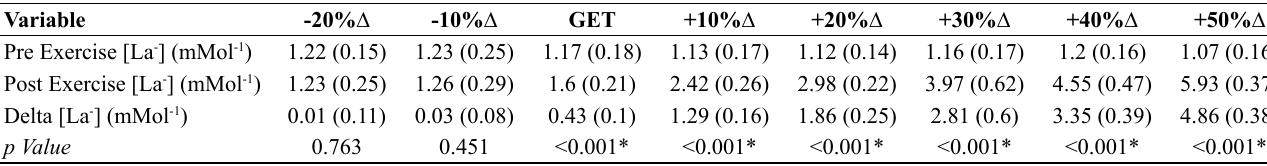
Table. 2. Average blood lactate responses as a function of exercise intensity.